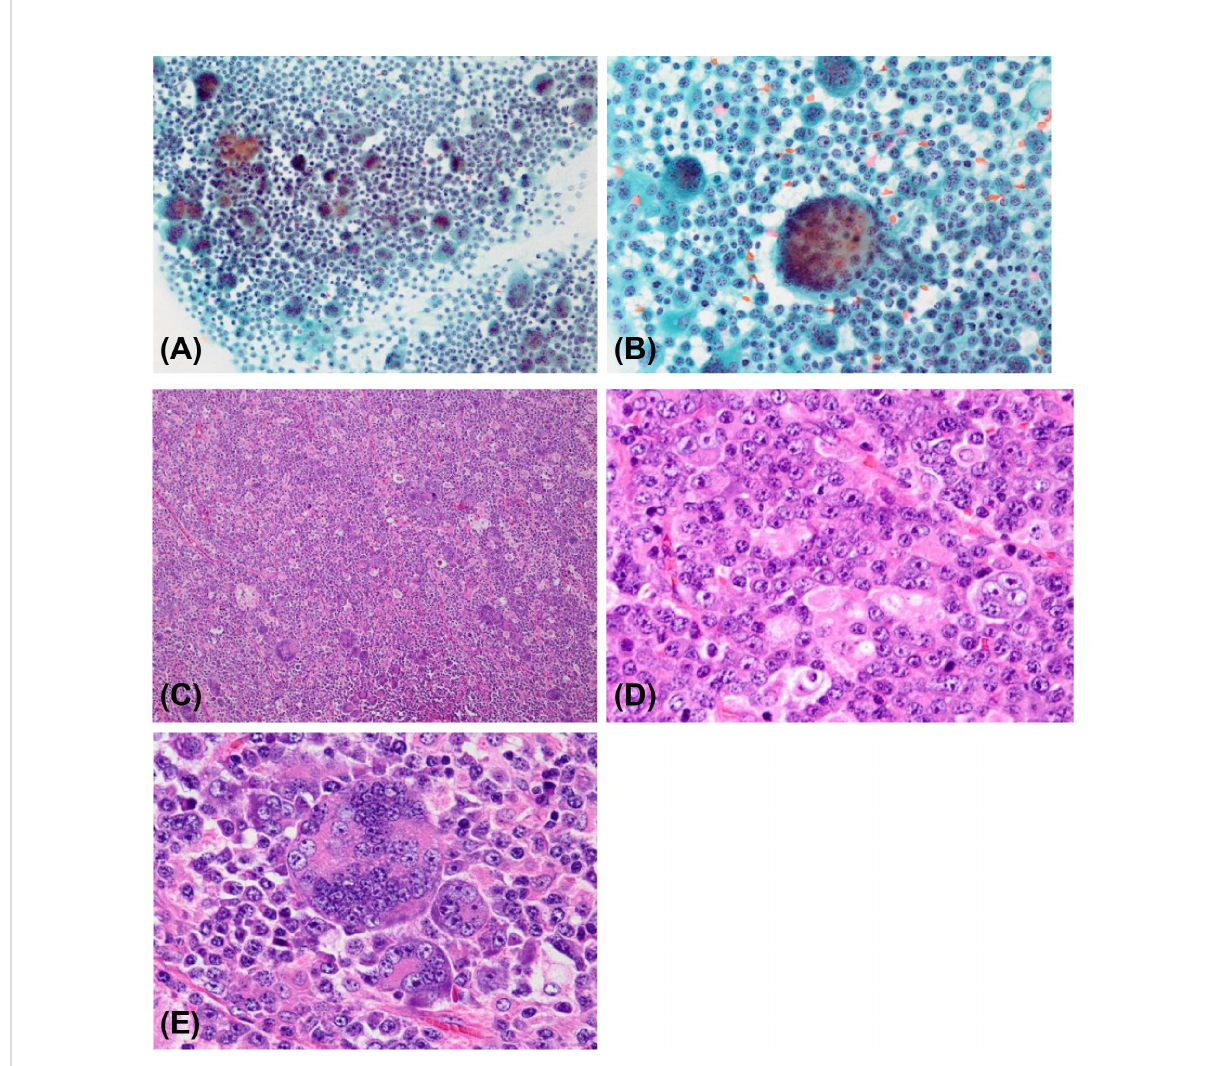
FIGURE 1 Cytological fi ndings. (A) Proliferation of mononuclear cells admixed with multinucleated giant cells (Papanicolaou staining, original magni fi cation ×20); (B) Multinucleated giant cells with dozens of nuclei (Papanicolaou staining, original magni fi cation ×40). Histological fi ndings. (C) The lymph node was almost replaced by the tumor, and its original architecture was lost (hematoxylin and eosin staining; original magni fi cation ×10); (D) Predominant mononuclear neoplastic cells with prominent nucleoli and basophilic cytoplasm (hematoxylin and eosin staining; original magni fi cation ×60); (E) Multinucleated giant cells with dozens of nuclei (hematoxylin and eosin staining; original magni fi cation